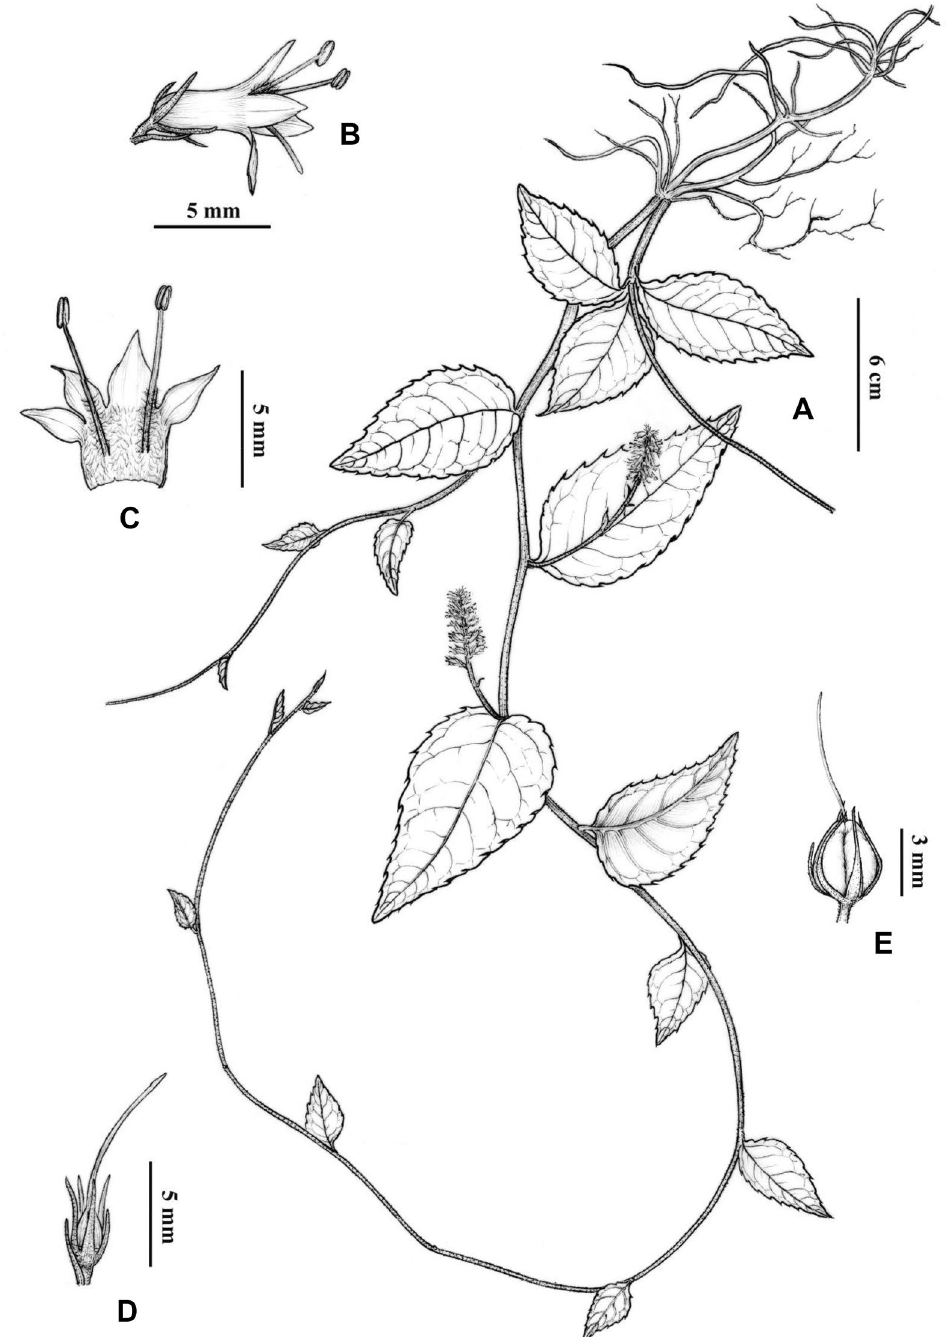
Fig. 2 Illustration of Veronicastrum wulingense . A habit; B flower; C dissected corolla and stamens; D calyx and pistil; E capsule with persistent sepals. Drawn by J.